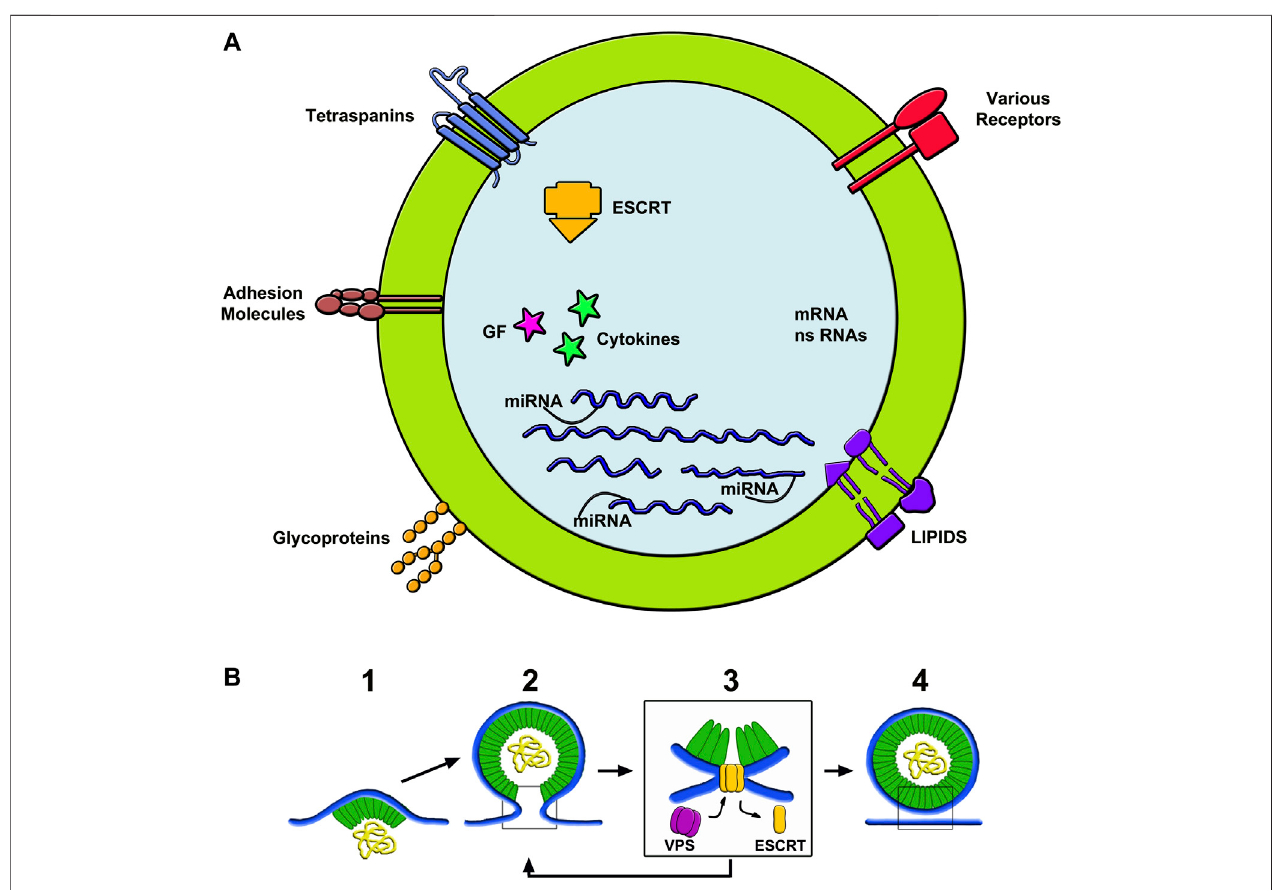
FIGURE 2 | Structure of exosomes (A) and assembly of ectosomes (B) . (A) shows the composition of the membrane and luminal cargos of an exosome. The components shown in the membrane are among the most abundant in these vesicles. The content shows numerous proteins, some of which bound to miRNAs. Other components are fl uid factors such as cytokines and growth factors shown as arrows. ESCRT complexes participate of membrane growth. mRNAs and ns-RNAs are other nucleotides accumulated here from the cytosol. (B) illustrates an example of ectosome rapidly assembled from the initial microdomain of the plasma membrane. To the left, 1) shows an initial curvature, already associated to a fi rst cargo, followed by its budding 2) and then by its fi ssion dependent on ESCRT-III interaction with VPS 3). To the right 4) the ectosome is free, ready to navigate in the extracellular fl uid. The ectosome yellow sequences shown in the (B) lumen correspond to those drown in the exosome lumen of (A)